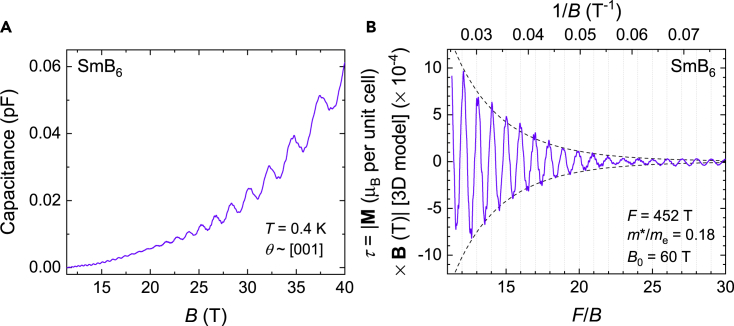
Absolute Amplitude of Magnetic Torque Quantum Oscillations in Pristine Floating Zone-Grown SmB6 Single Crystals(A) Quantum oscillations in the magnetic torque of a floating zone-grown single crystal of SmB6 are sizable compared to the paramagnetic background, before any background subtraction. Oscillations corresponding to the high frequencies originating from the α branches are also visible.(B) De Haas–van Alphen oscillations in absolute units of magnetic moment corresponding to the F = 452 T oscillations after a smooth monotonic background was subtracted. The dashed lines represent the magnetic field dependence of the quantum oscillation amplitude from the impurity scattering (Dingle) damping term for a damping factor B0 = 60 T.